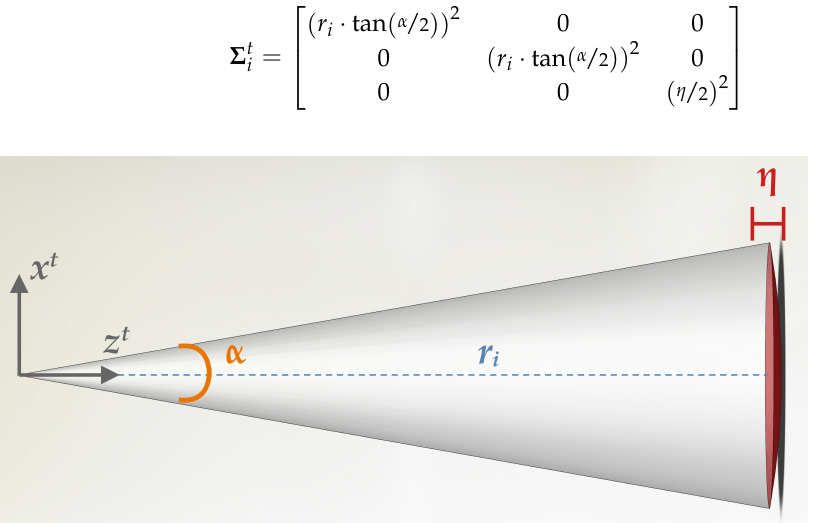
Figure 2. Illustration of the probabilistic beam model adopted by the 3DupIC to represent each single scan